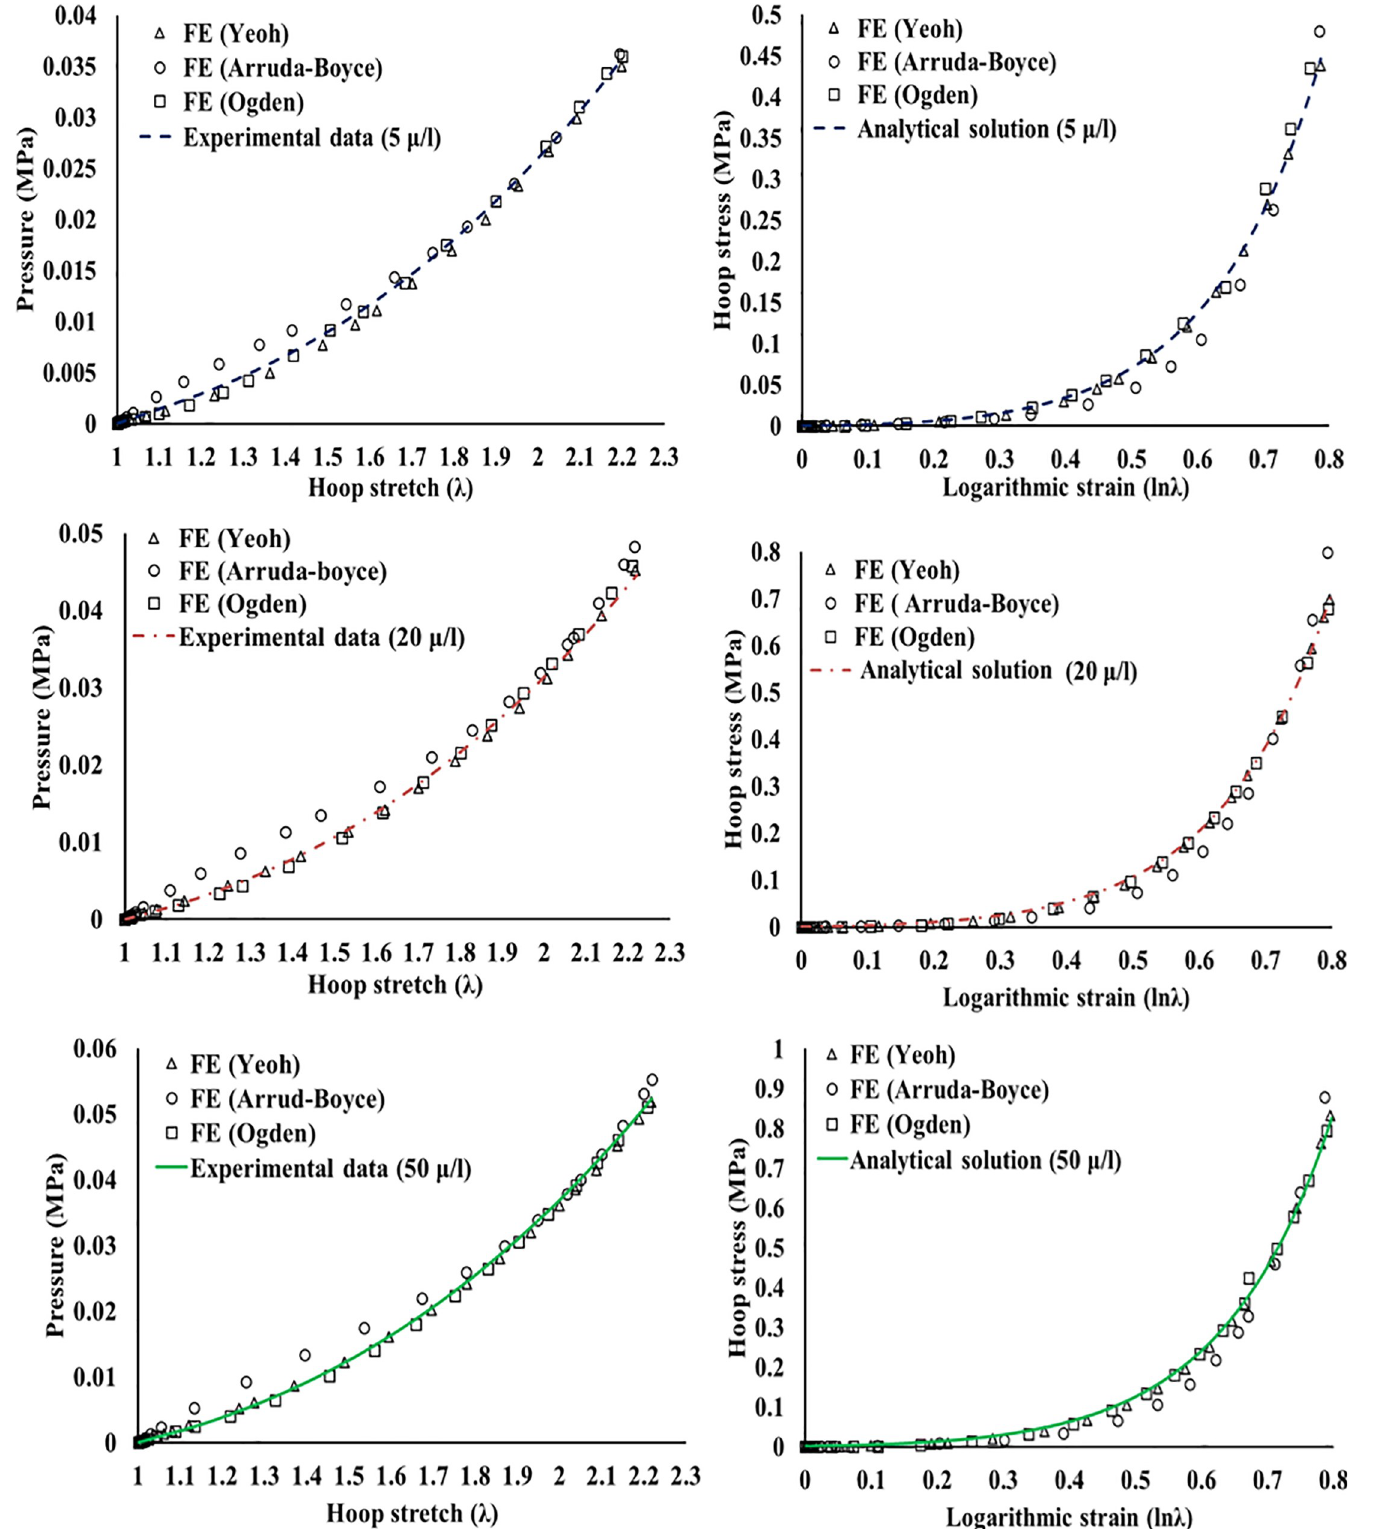
Fig 8. Experimental, numerical, and analytical results. The numerical results compared against the experimental pressure and the analytical hoop stress at each deformation rate.